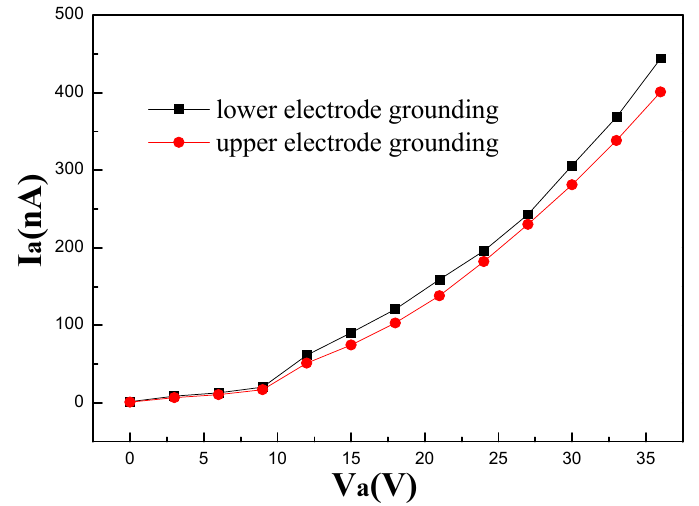
Figure 4. Current–voltage curves of lower electrode and upper electrode grounding.